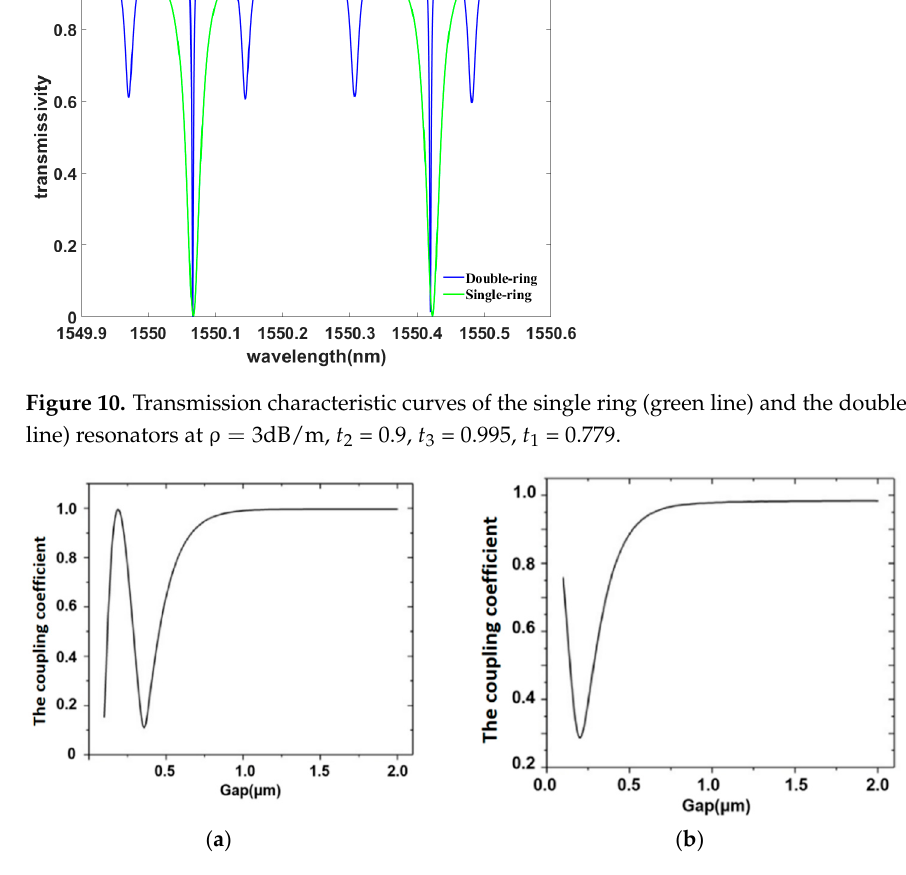
Figure 11. ( a ) The coupling coe ffi cient of the coupling region of the straight-ring waveguide at di ff erent coupling gap and ( b ) the coupling coe ffi cient of the coupling region of the ring–ring waveguide at di ff erent coupling gap.